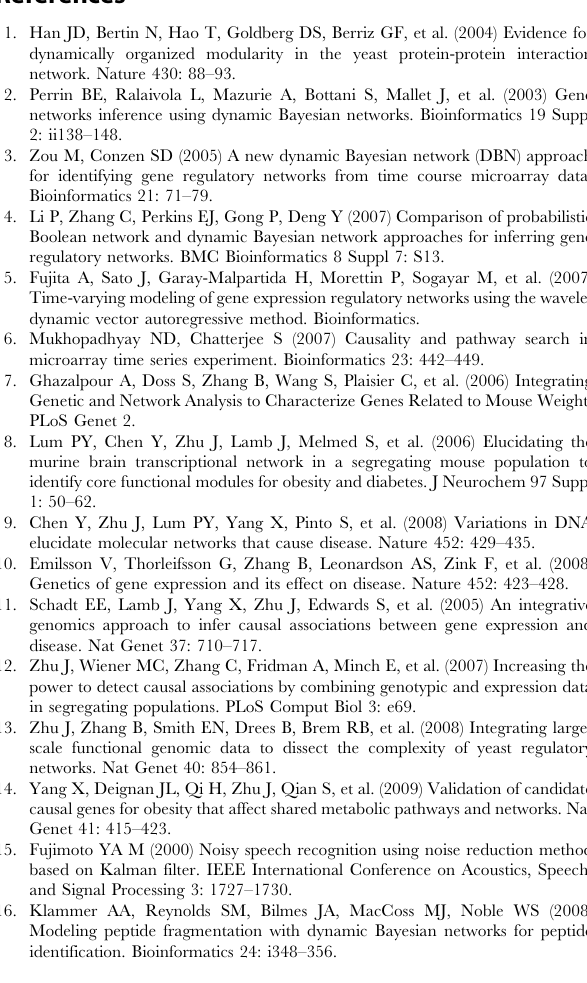
Figure S1 A Montage display of independently simulated time series for X R Y based on Equation 1. Each time series consists of 240 time points (only the first 50 points are shown here). Blue lines are for X , and red lines are for Y . Figure S2 Prediction accuracies of Granger causality X R Y using the simulated time series shown in Figure S1. Each full series consists of 240 time points and each short series consists of 6 time points. Figure S3 The distributions of bootstrapping confident values of links inferred in both fast and fed Granger causality networks. (A) 80% links in the fast network have confident values above 0.5 (B) 90% of links in the fed network have confident values above 0.5. Figure S4 The out-degree distributions of both fasted and fed Granger causality networks exhibit scale-free properties. (A) The out-degree distribution for the fasted network; (B) the out-degree distribution for the fed network. Table S1 Inferred causal links in the fast blood Granger causal network.